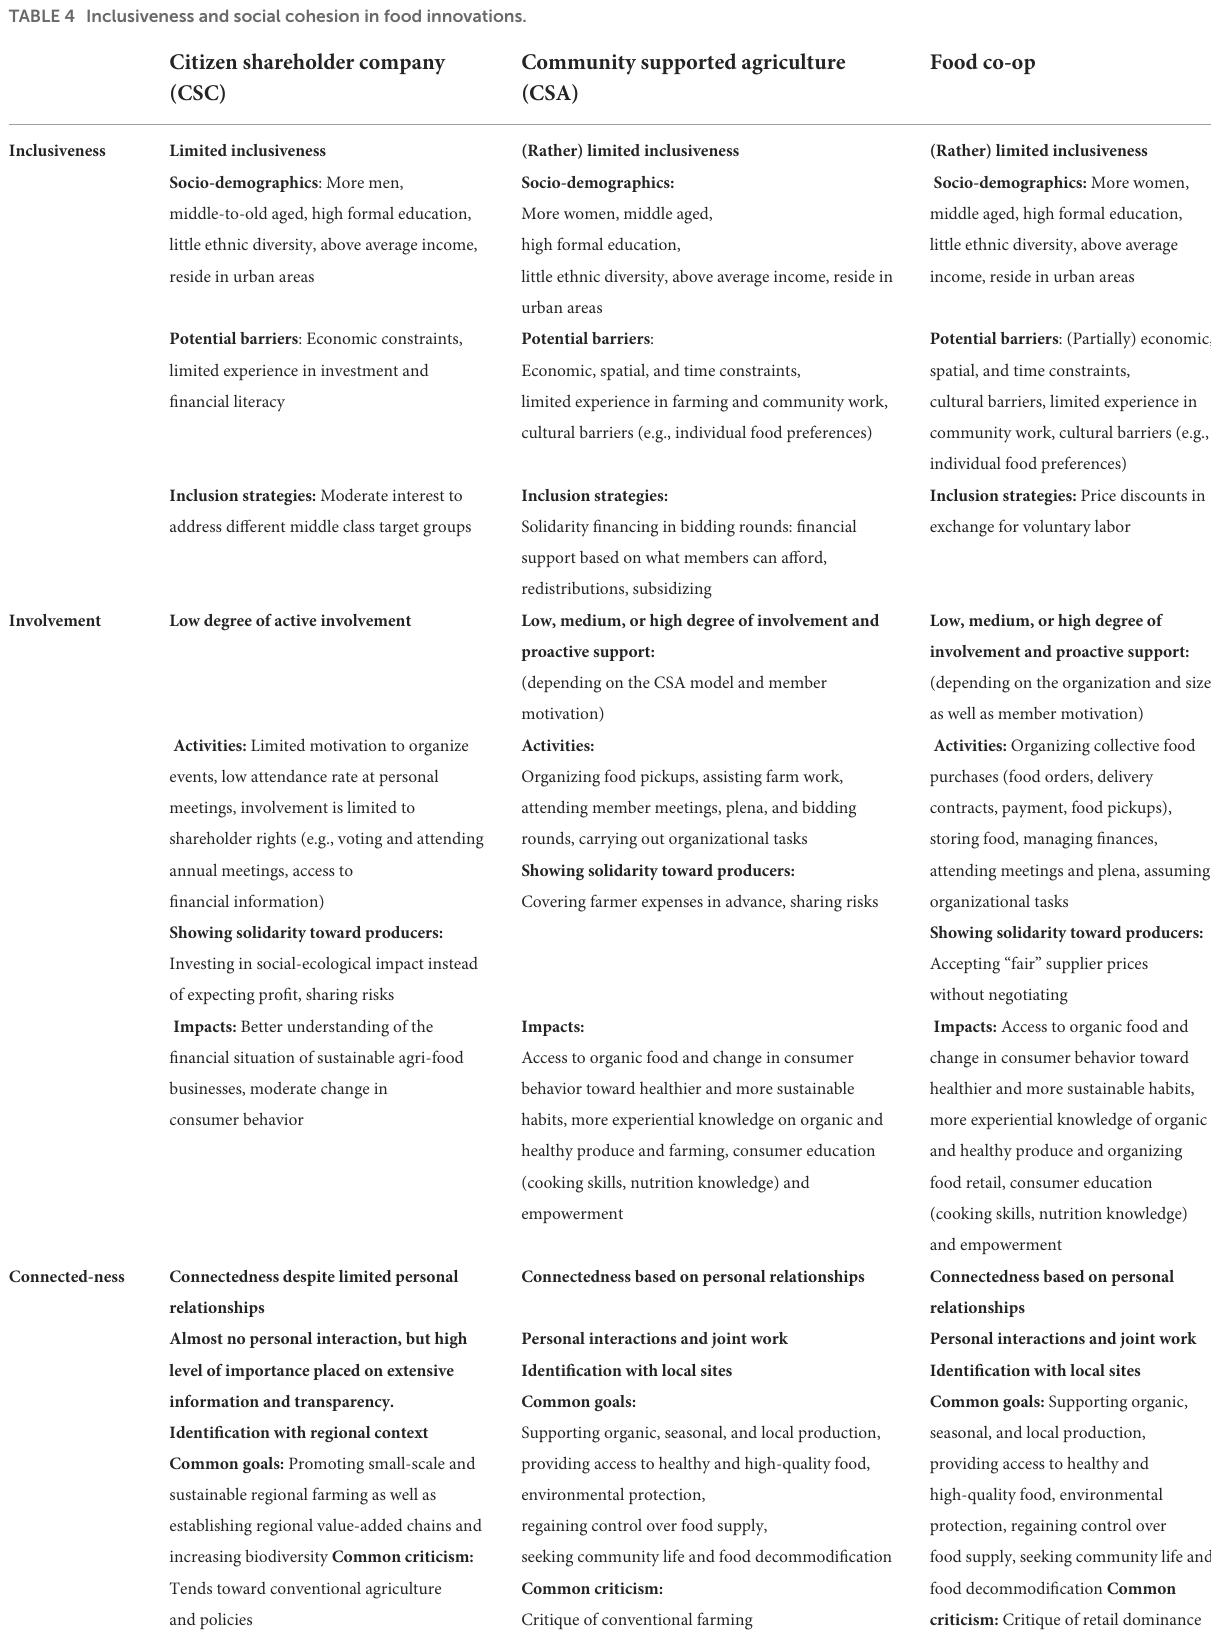
TABLE 4 Inclusiveness and social cohesion in food